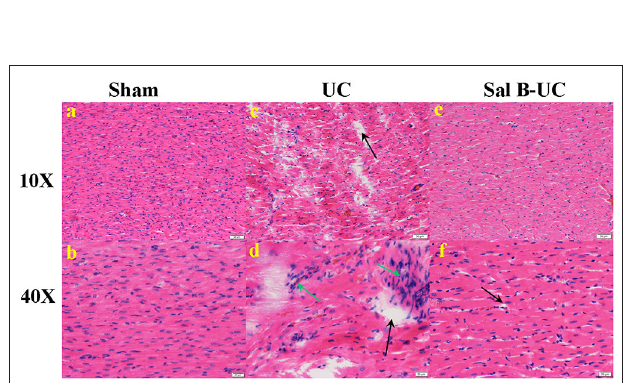
FIGURE 3 | Histological analysis. The histopathological images (10 × and 40 × ) in the sham, UC, and Sal B-UC groups. (A,B) Myocytes are arrayed in parallel, with no inflammatory cell infiltration in the sham group. (C,D) Distorted cardiomyocytes, mononuclear cell infiltration (green arrow), and interstitial edema with necrosis (black arrow) in the UC group. (E,F) Mild edema with little inflammatory cell infiltration in the Sal B-UC